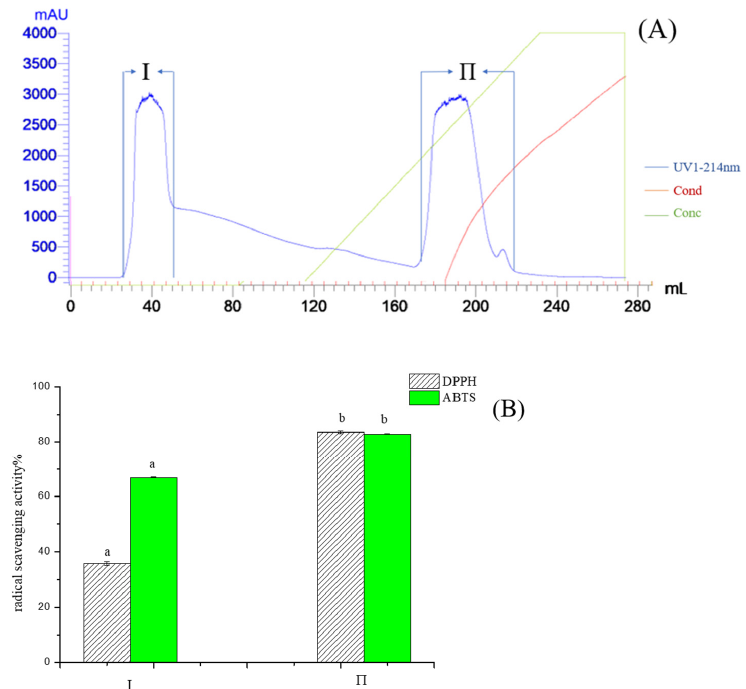
Figure 2. Elution profile of PPH-I on Q Sepharose Fast Flow column (1.6 × 30 cm), and activities of each fraction. ( A ) Chromatogram profiles of PPH-I; ( B ) DPPH and ABTS radical scavenging activities of fraction I and fraction II. Different letters in the same test indicate significant differences ( p < 0.05).